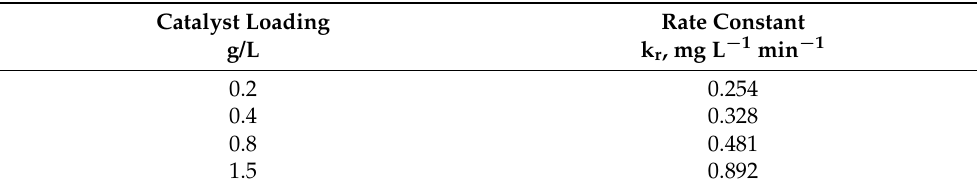
Table 4. Langmuir-Hinshelwood constant (k r ) values at different catalyst loadings.